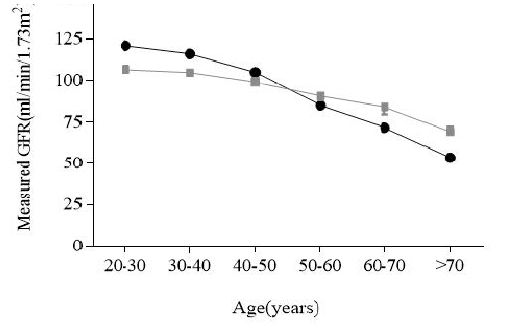
Figure 3 . Comparison of the mean and confidence interval obtained in the present study and the standard values reported in the meta-analysis.